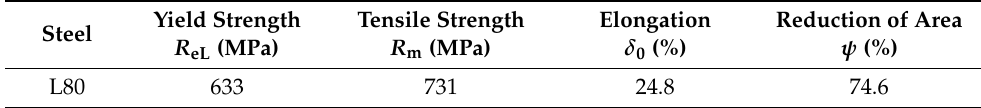
Table 2. Mechanical performance of L80 steel used in this study.